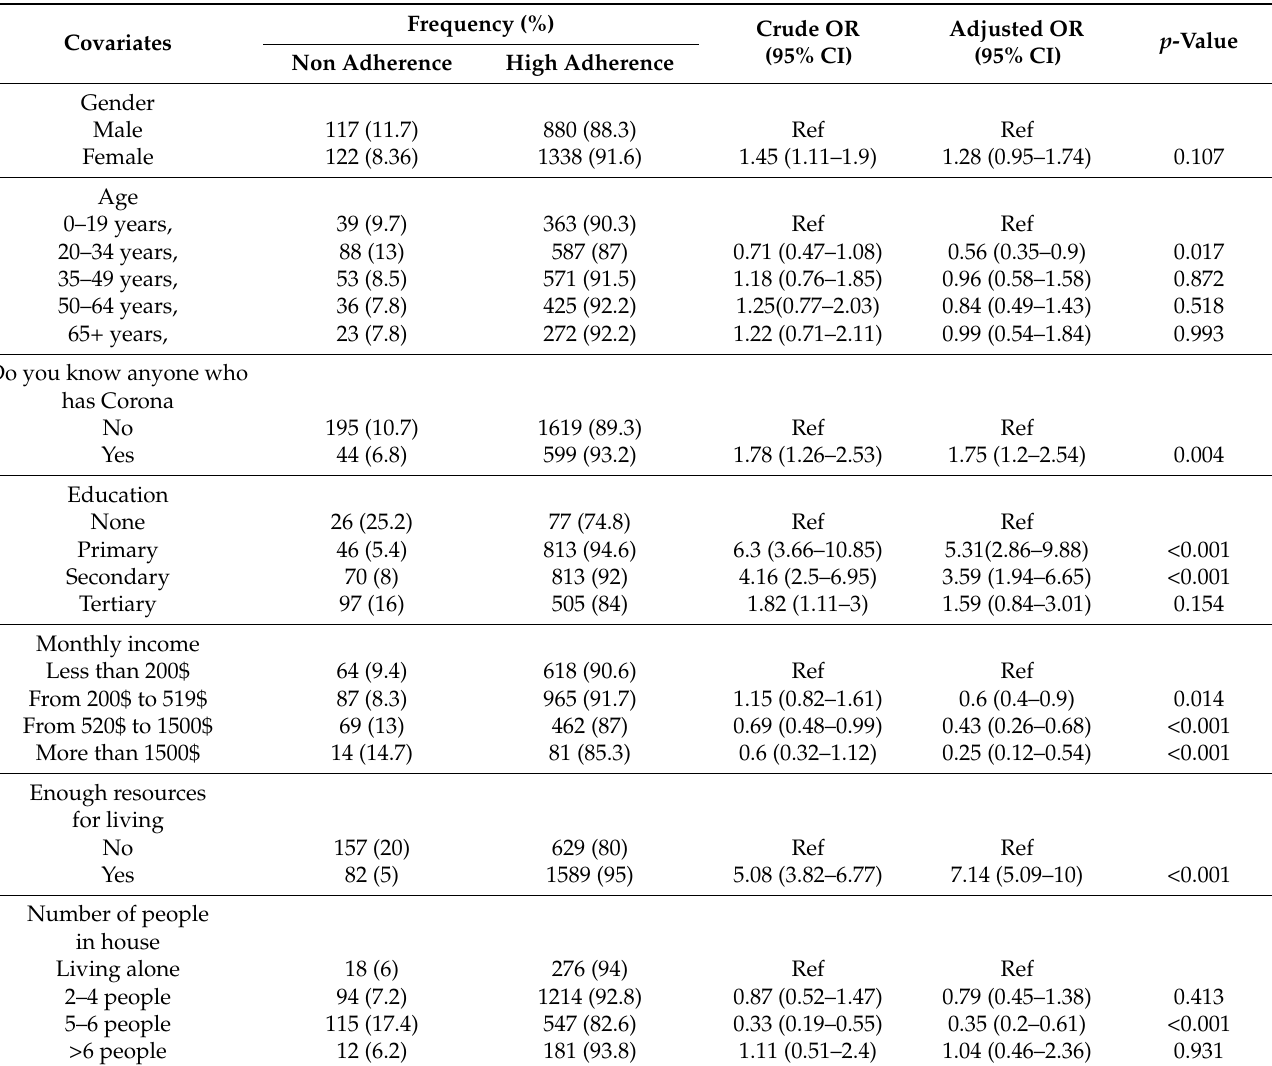
Table 4. Factors associated with adherence to COVID-19 preventive